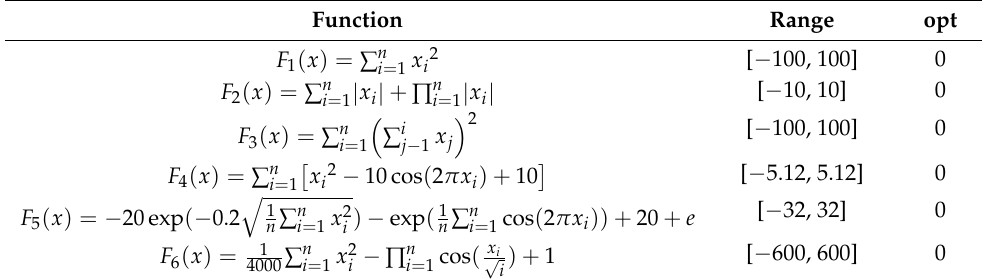
Table 1. Benchmark test functions.